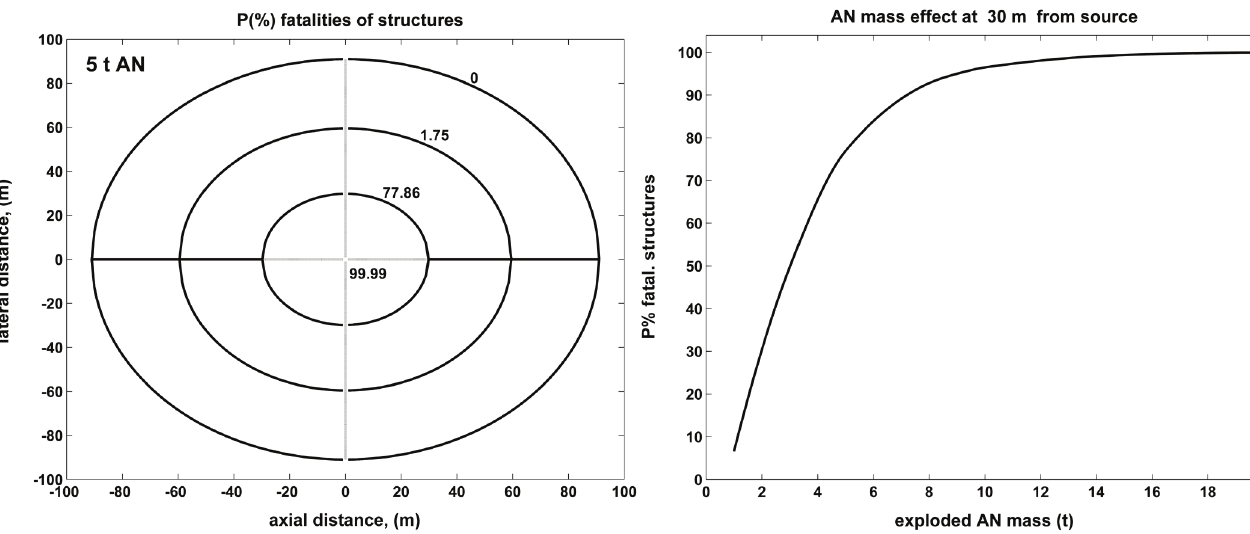
Fig. 7 – P% fatalities of structures (buildings, adjacent cars, etc.) at 30 m distance from the explosion source, for various amounts of exploded